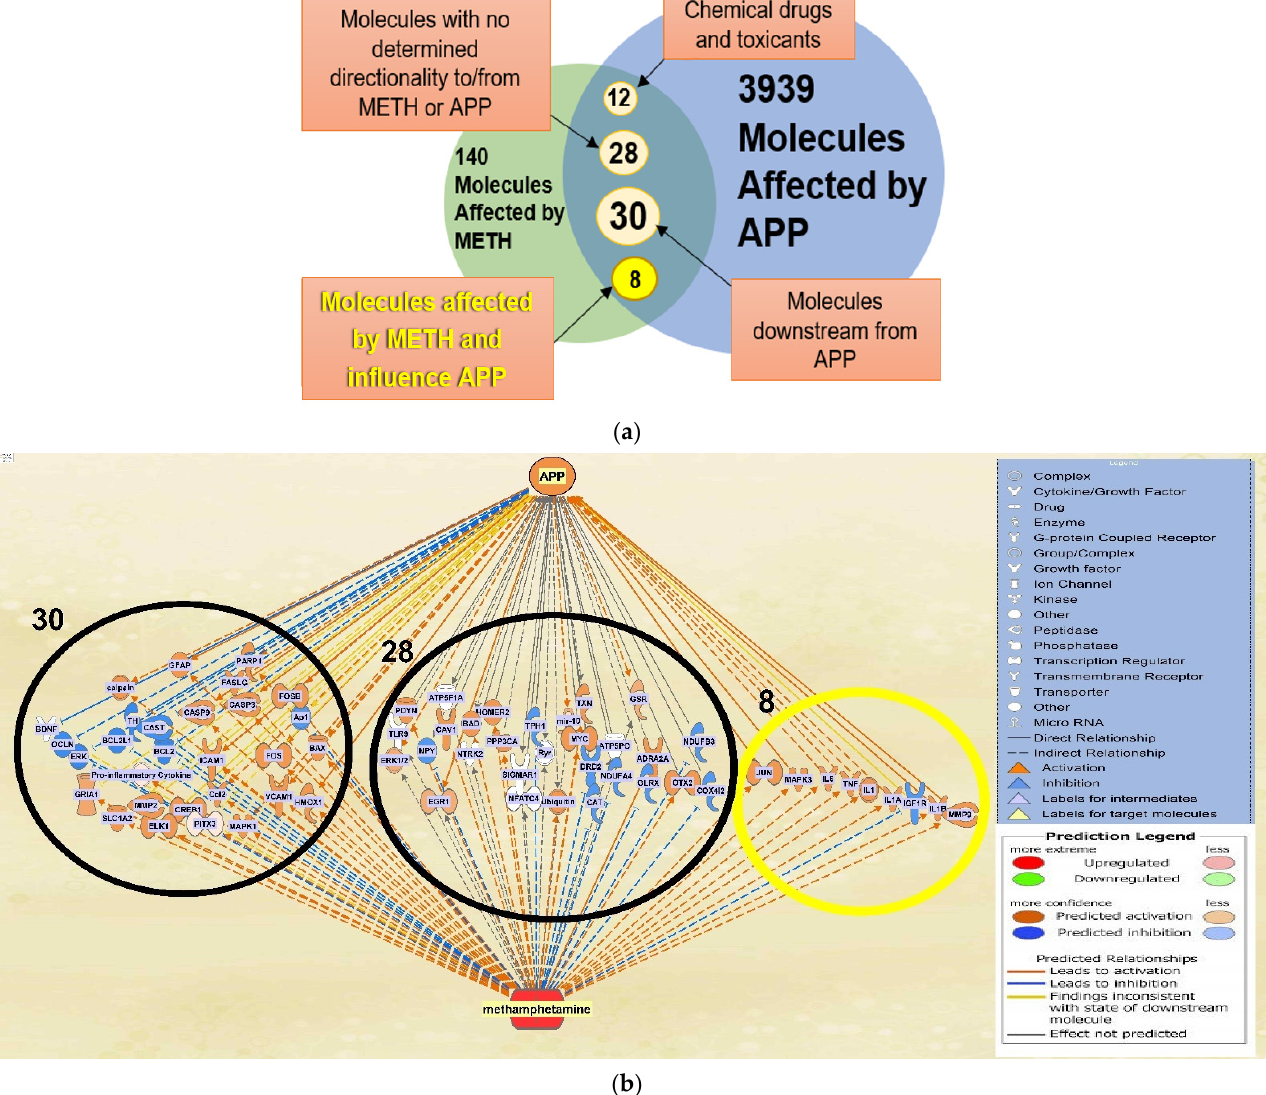
Figure 2. Categorization of the overlapping molecules. ( a ) The 78 overlapping molecules affected by METH and APP are categorized into groups to identify the molecules to be investigated further in the analysis, in which the impact of METH exposure influences APP expression; ( b ) the 78 overlapping molecules affected by METH and APP that were categorized into groups can be seen in clusters within the network (grey lines indicate an undetermined expression change) to offer an overview of the original overlapping network, sans the 12 chemical drugs and toxicants.